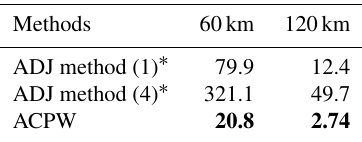
Table 8. The time consumption of the ADJ method and the ACPW algorithm (unit: min). The bold numbers represent that the ACPW has the minimum time